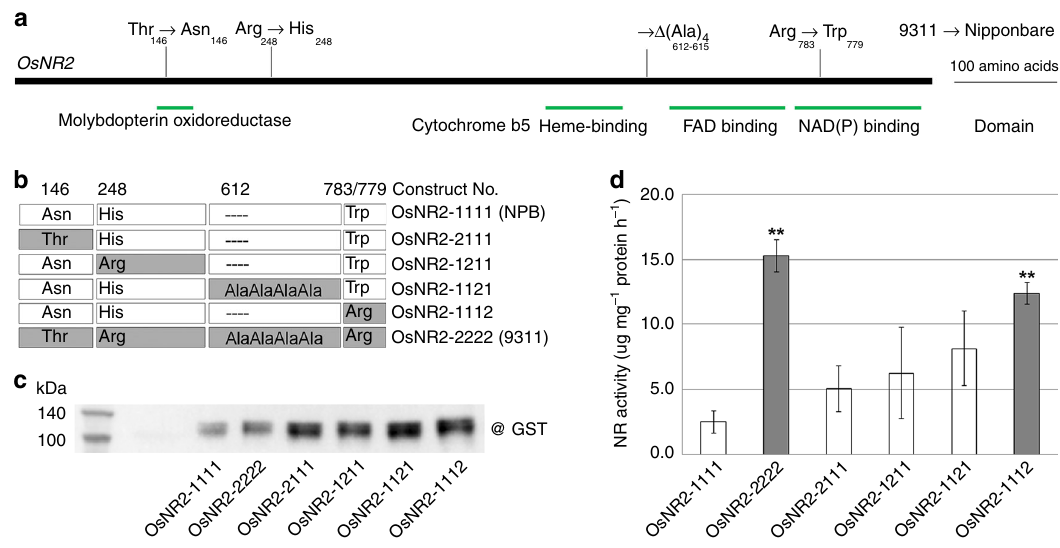
Fig. 2 An Arg-Trp amino acid substitution reduces the speci fi c activity of Nipponbare OsNR2. a Amino acid substitution and insertion differences between the 9311 and Nipponbare OsNR2 proteins. Locations of conserved functional domains are indicated by green bars. b Constructs expressing chimeric OsNR2 proteins of varying amino acid sequence. Fragments from the 9311 and Nipponbare OsNR2 coding regions were exchanged to generate constructs encoding a series of four different chimeric OsNR2 proteins, differing with respect to the amino acid residues variant between 9311 and Nipponbare OsNR2. These constructs were expressed in E.coli . c Detection with anti:GST antibody (Cat No: CW0084M, CWBIOtech, Beijing, China) of OsNR2-GST fusion proteins extracted from E. coli and puri fi ed on a GST-se fi nose TM column (constructs as shown in b ), showing roughly equivalent abundance of OsNR2 proteins. d NR activity of puri fi ed extracts as in b , c . Value is mean ± s.d. ( n = 3). Error bar represents s.d. ** indicates the least signi fi cant difference at 0.01 probability level compared with Nipponbare. The source data underlying c and d are provided as a Source Data fi le